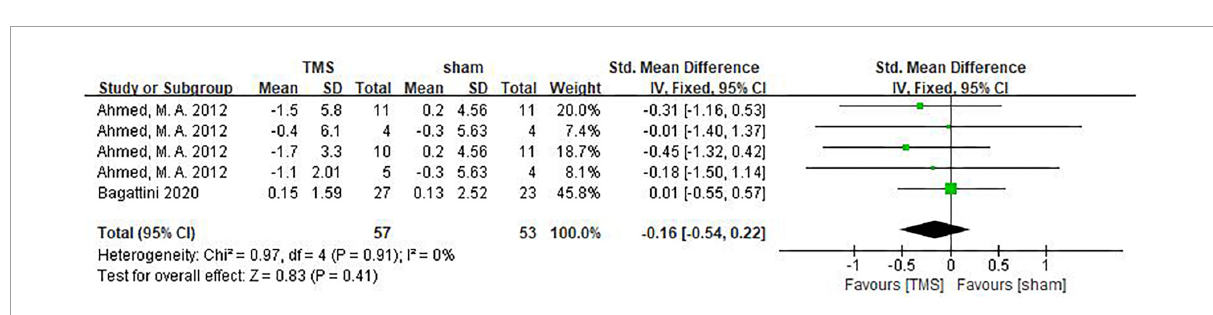
FIGURE12 Forest plot showing the effect of repetitive transcranial magnetic stimulation (rTMS) on GDS of AD patients with 95%